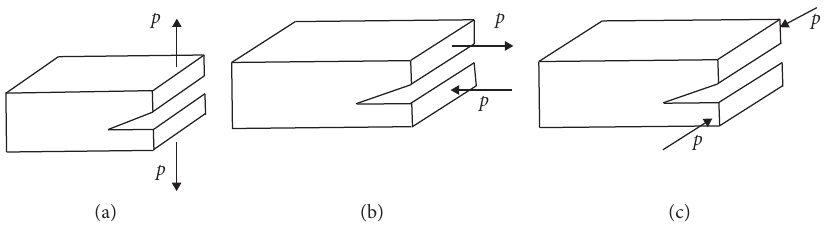
Figure 1: Three basic types of cracks Anderson [3]. (a) Type I. (b) Type II. (c) Type III.